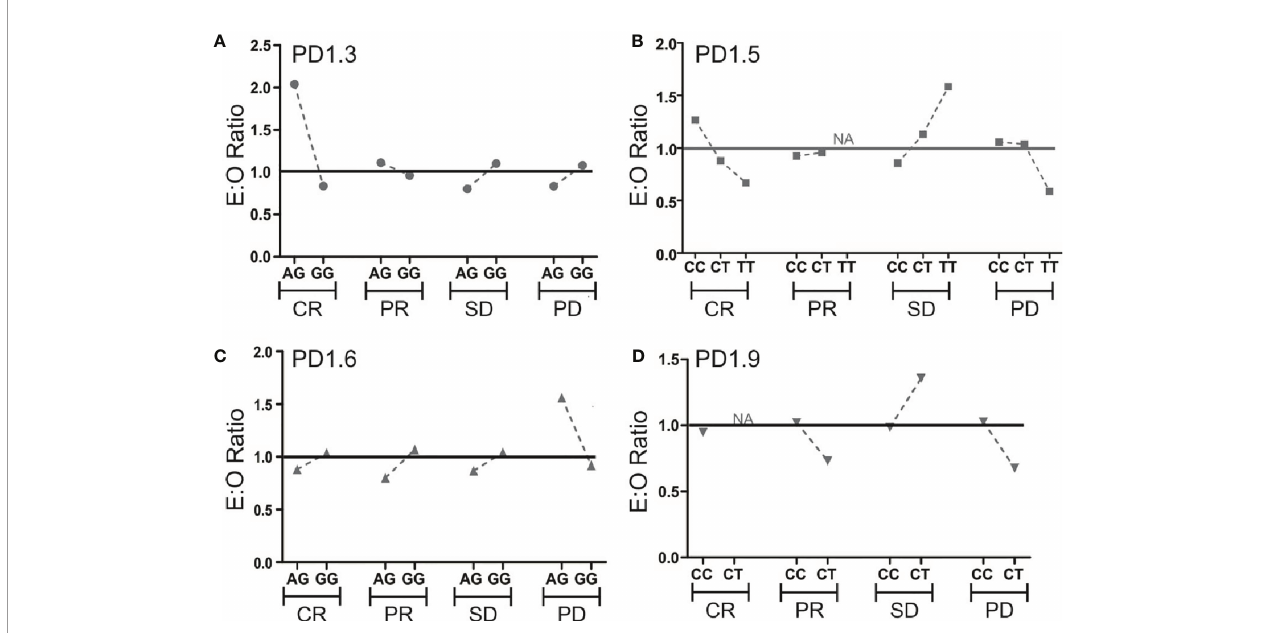
FIGURE 1 | Expected (E)-to-observed (O) ratio of responses according to PD-1 SNP. Responses for all 4 SNPs (A – D) are shown as complete response (CR), partial response (PR), stable disease (SD) or progressive disease (PD) by dividing number of expected responses by number of observed responses within each genotype. The solid line at y=1 represents a theoretical E:O ratio of 1:1. NA signi fi es data points where one genotype had 0 events.